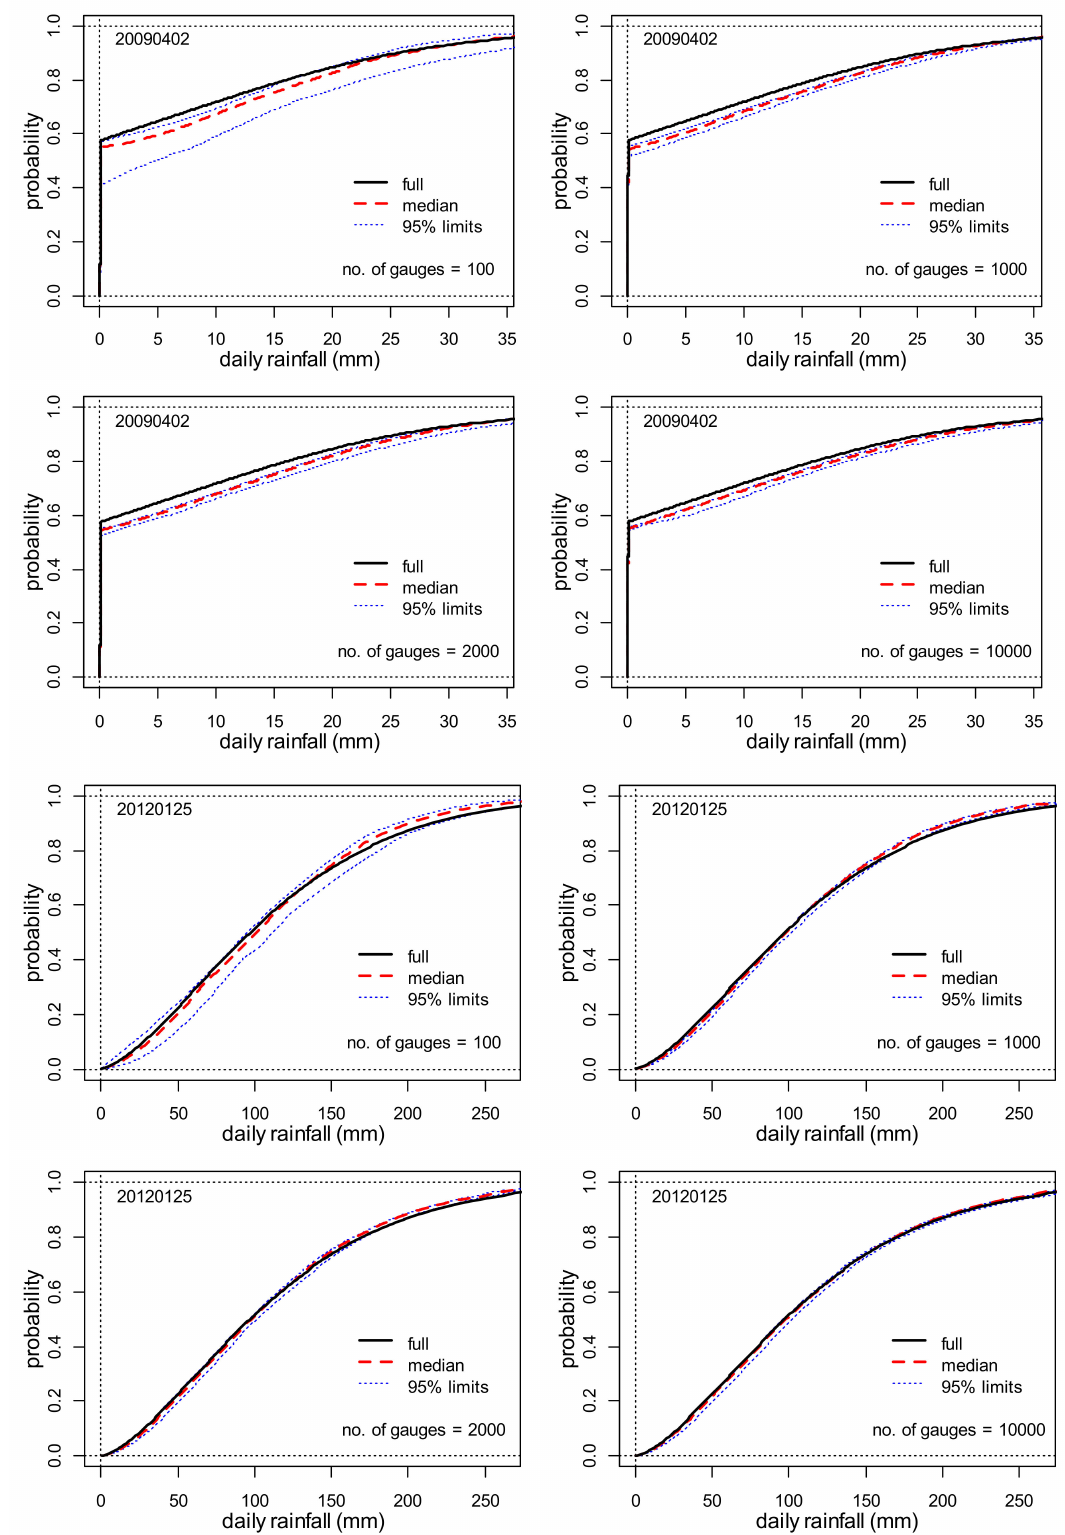
Figure 6. Variation of the median marginal distribution of the sampled data for a given number of rain gauges; the 95% prediction limits are shown in dotted blue lines; top four plots are for 20090402 (wet proportion < 0.5) and the bottom four plots are for 20120125 (wet proportion =